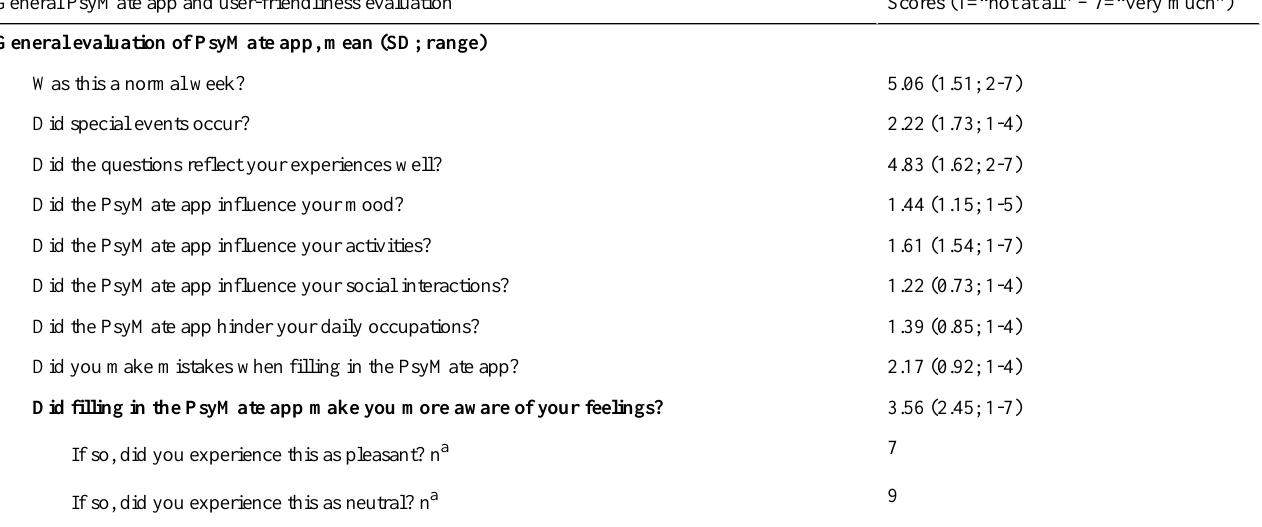
General evaluation of PsyMate app, mean (SD;